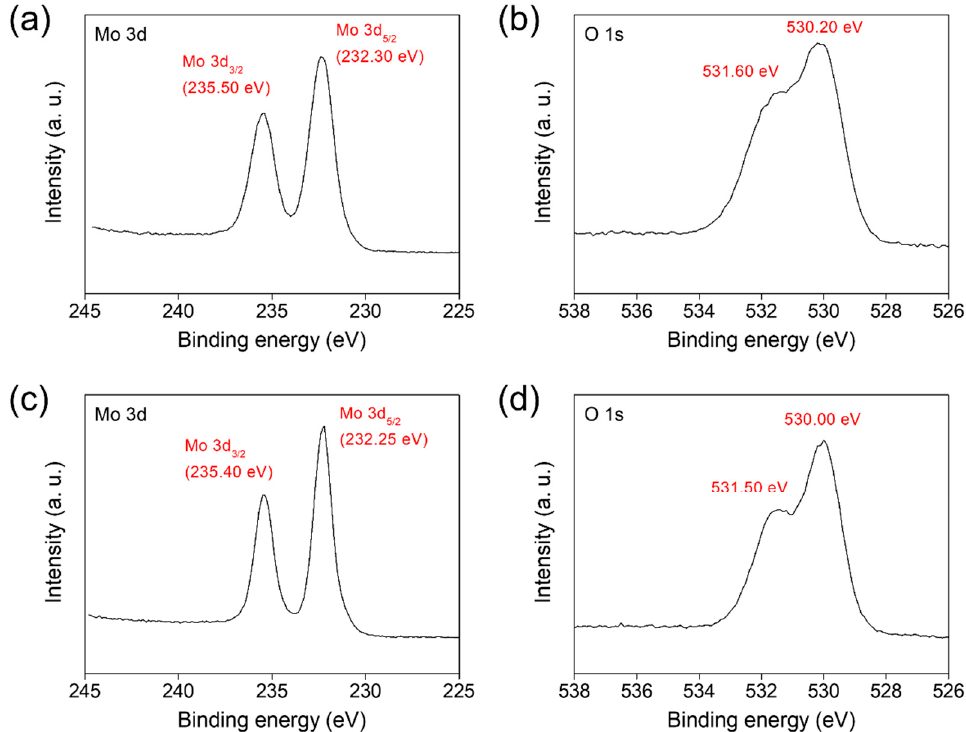
Figure 6. XPS spectra of Mo 3 d and O 1 s acquired for the molybdenum oxide nanoparticle aggregates